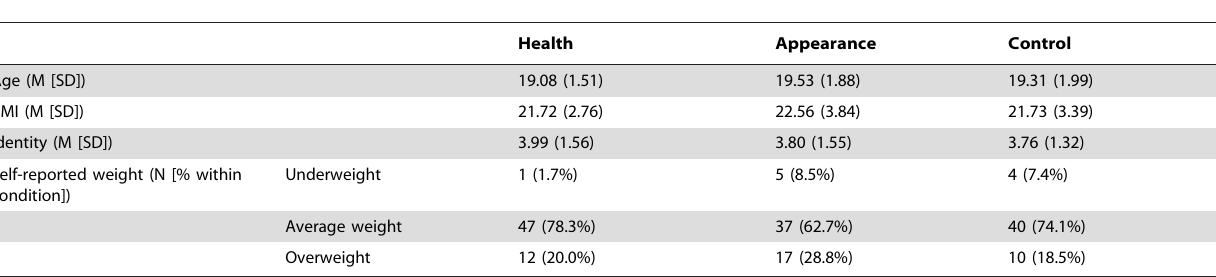
Table 1. Demographic characteristics of the sample by experimental condition.